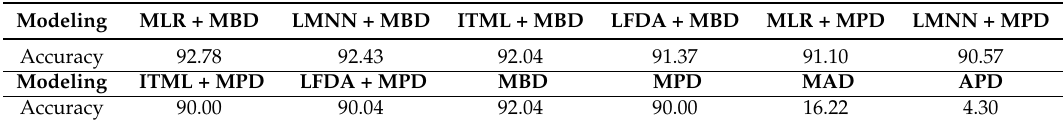
Table 8. Modeling component analysis on